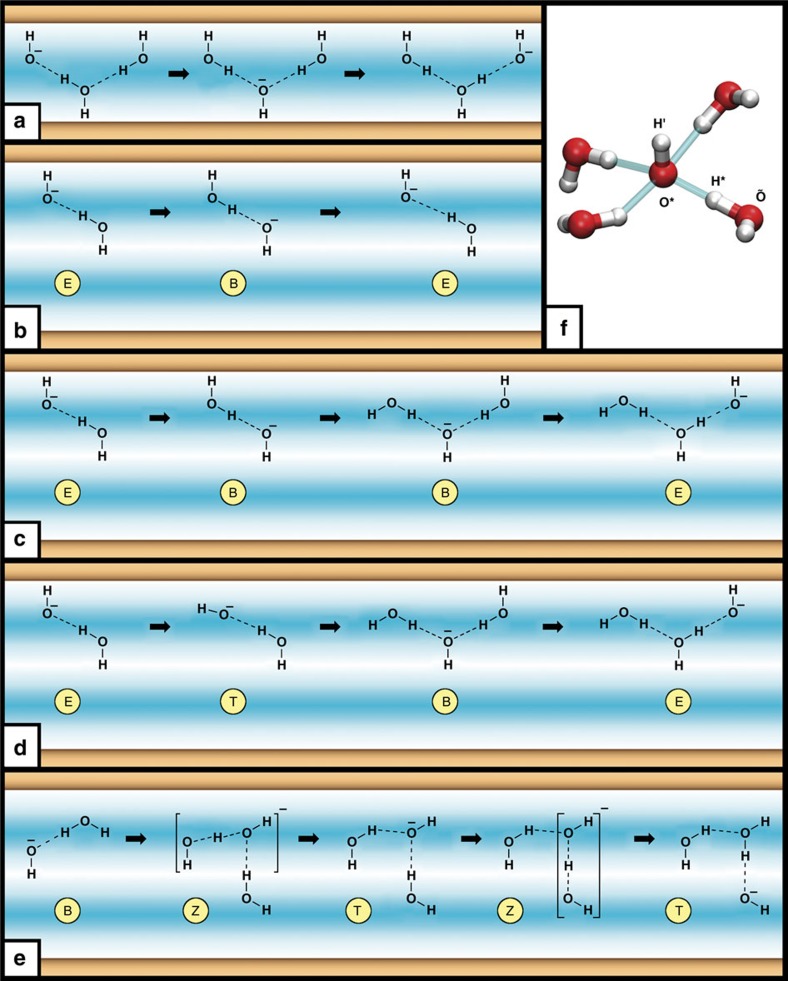
Schematic representation of the distinct proton hole migration mechanisms.Schematic representation of the distinct proton hole migration mechanisms in the narrow and wide slit pores, that is, system N in (a) and system W in (b–e). The top and bottom confining surfaces are schematically included as brown bars, whereas the high/low-density water regions are represented using light/dark blue shading, to visualize the water monolayer/bilayer structure of the water film in system N/W, respectively. Only key species and hydrogen bonds (dotted lines) are shown in terms of chemical formulae, thus omitting the full solvation shell of the OH− defect (with the negative charge symbol attached to it, see also f). In the narrow pore limit, the preferred zig–zag migration path of OH− is depicted in a. In the bilayer pore W, one can distinguish proton (hole) rattling relative to the ‘exposed' state E without net charge migration (b), structural diffusion via the ‘exposed'–‘buried'–‘exposed' E–B–E (c) and ‘tilted'–‘buried'–‘exposed' T–B–E (d) mechanisms, as well as structural diffusion via alternating ‘tilted' and ‘buried' configurations (e), which stabilizes the trapped Zundel intermediate Z (see text) as symbolized in e using square brackets; see Fig. 5 for definitions. The standard notation employed for the solvated OH−(aq) complex is depicted in f using a representative snapshot of the preferred hypercoordinated resting state as sampled at the interface. Here, O* and H′ denote the site of the hydroxide anion, whereas H* and Õ are the sites of the particular water molecule, which donates the most active hydrogen bond along which proton (hole) transfer will eventually occur.